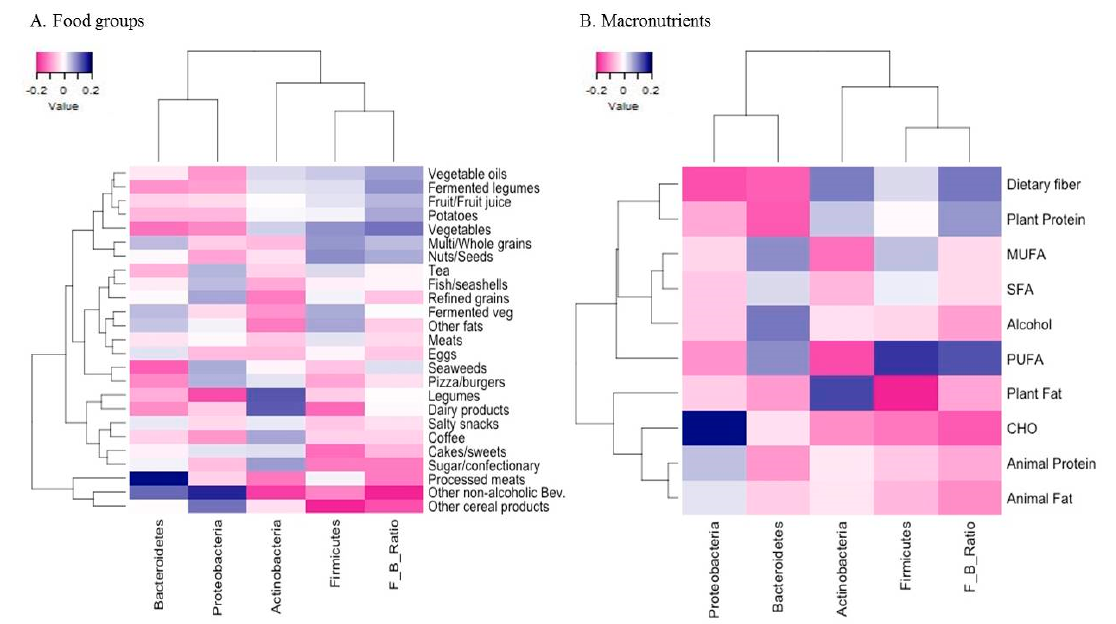
Figure 1. Heatmaps of partial Spearman correlations between the relative abundance of four major phyla and the Firmicutes-to-Bacteroidetes ( F/B ) ratio of the gut microbiota and the intakes of food groups ( A ) and macronutrients ( B ) in Korean adults of the NAS-IARC cross-sectional study ( n = 222 participants). Partial Spearman correlation analysis adjusted for sex, age, BMI, dietary supplement intake, physical activity, smoking status, and sample batch; Intakes of food groups and macronutrients were log-transformed and adjusted for total energy intake using the residual method; the relative abundance of four major phyla and the F/B ratio of the gut microbiota were centered log-ratio transformed.